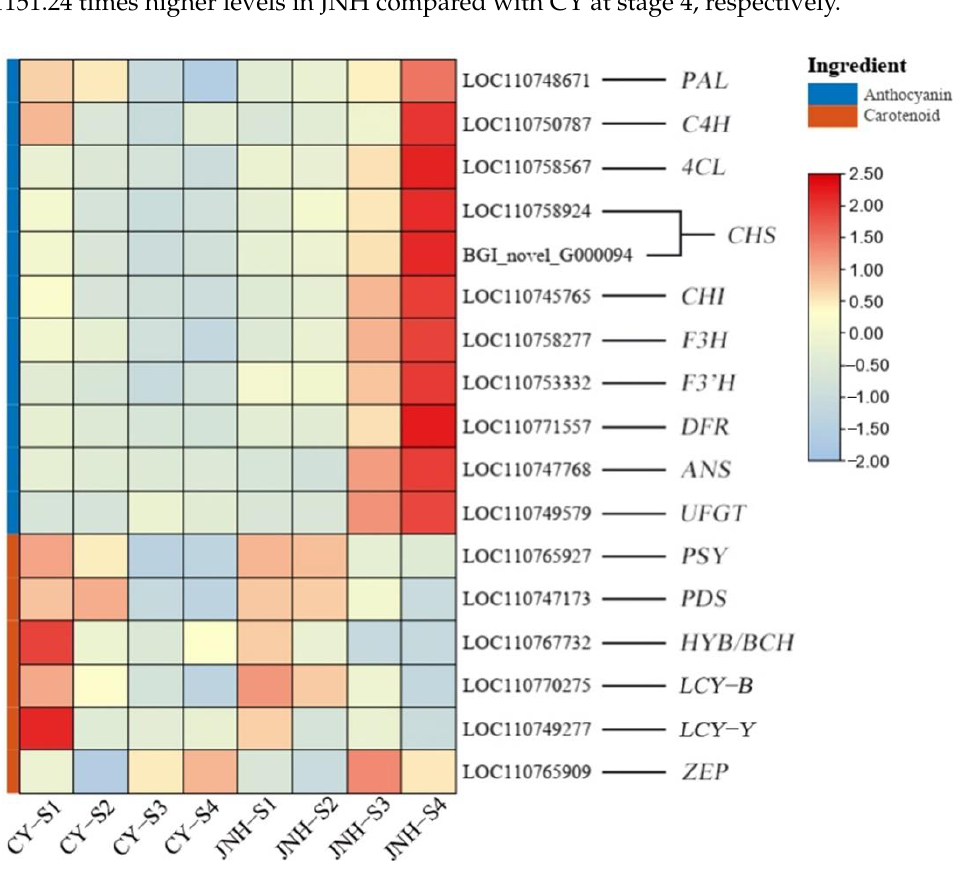
Figure 3. Visualizing heatmap of structural gene expression of anthocyanin and carotenoid in the fruit of sweet cherry. S1, S2, S3, and S4 refer to the four different ripening stages of JNH and CY. The underlying transcriptome mapping data are presented in Table S3.